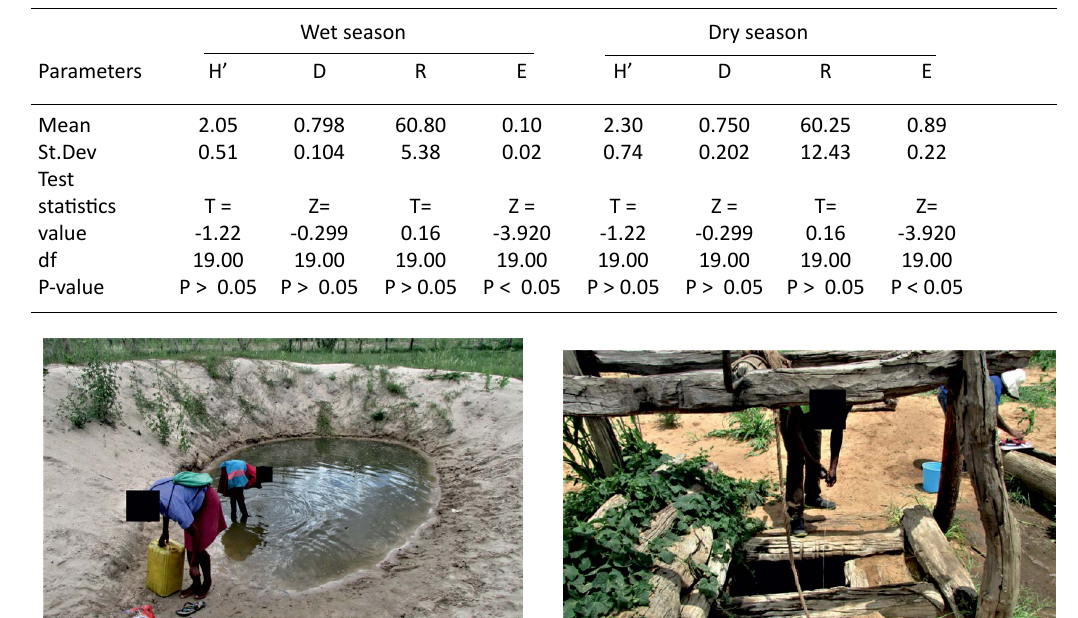
table 2. Tests performed to determine the influence of season on human pathogenic bacterial species richness (R), evenness (E) and diversity [Shannon (H’) and Simpson (D)]